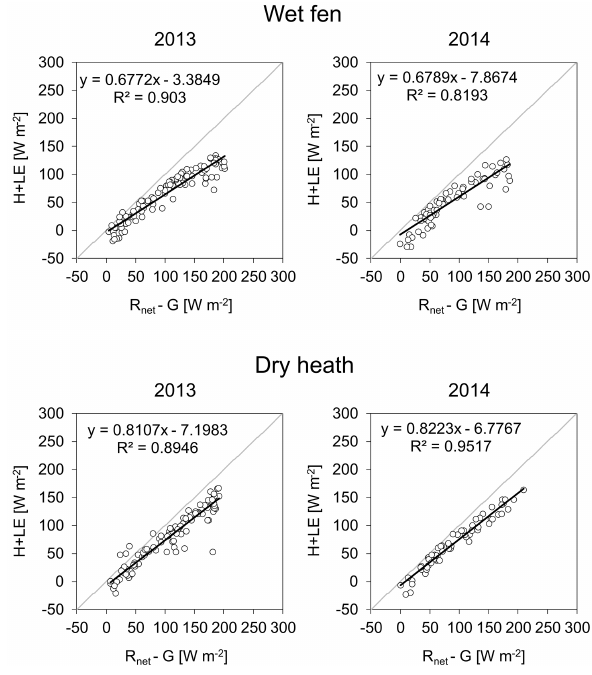
Figure 2. Energy balance closure: mean daily available energy ( R net − G ) and turbulent heat fluxes ( H + LE) at the wet fen (up- per panels) and the dry heath (lower panels) during the observation periods in 2013 and